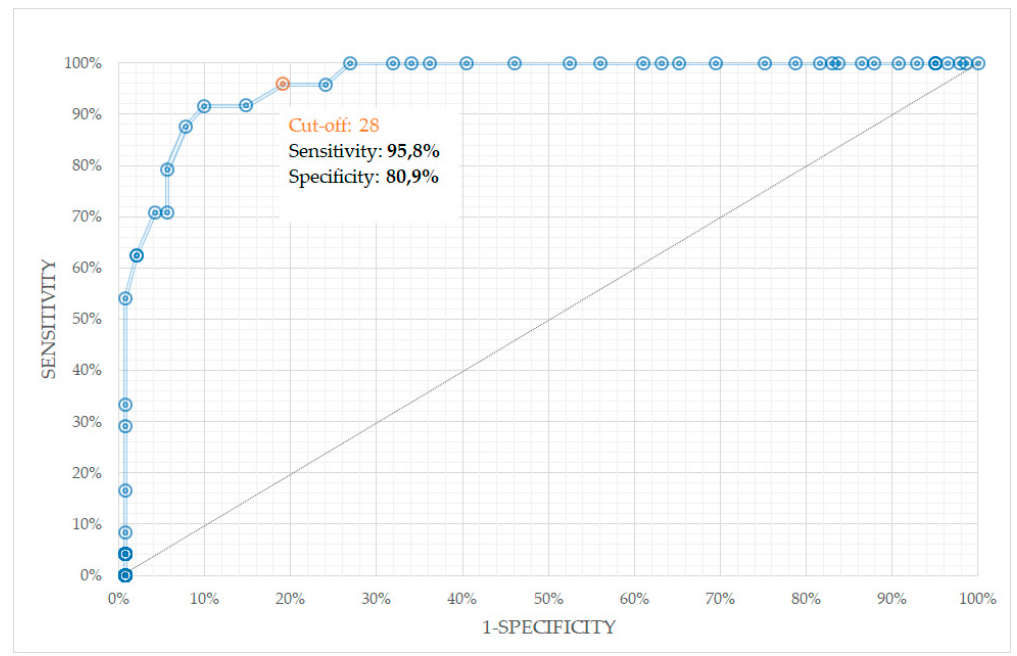
Figure 3. Receiver operating characteristics (ROC) curve of the best support vector machine (SVM) classifier, validated on 165 lesions, where the ROI-normalization factors were implemented in the final score calculation.